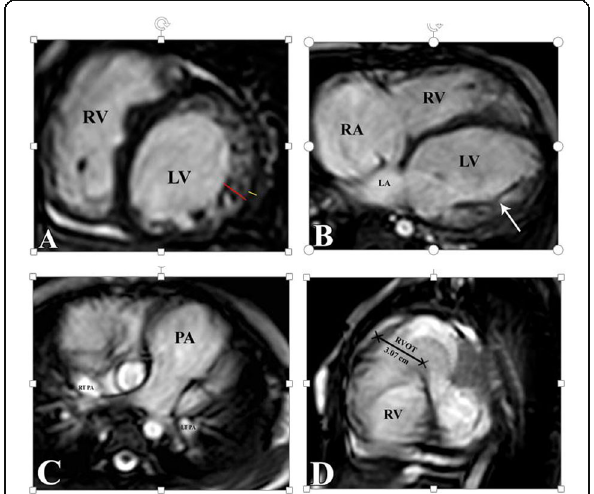
Fig. 5 a – d LVNC and picture of pulmonary hypertension. Three- year-old male patient presented with signs of pulmonary hypertension. Cine steady-state free precession (SSFP) in short axis and four-chamber cine images ( a , b ). Short axis image in diastole with red line denotes the thickness of the non-compacted myocardium, yellow line denotes the compacted myocardium and prominent trabecular network along the mid anterior, lateral, and inferior left ventricular wall segments with maximum thickness of non-compacted to compacted area in end diastole = 3.6 correlates with LVNC criteria (normal reference > 2.3). Both images ( a , b ) show dilated left ventricle with global hypokinesia, reduced EF (6.2%). There is marked dilatation of right ventricle which shows reduced ejection fraction (8.2%) associated with global hypokinesia and prominent trabeculation. There is dilated RVOT, pulmonary artery, and its two branches ( c, d